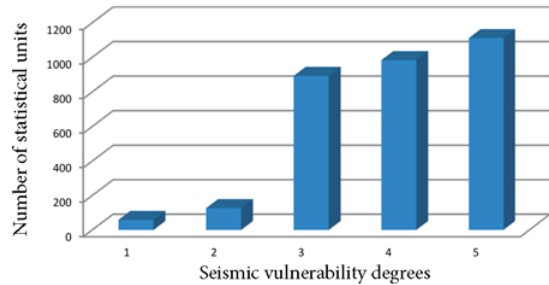
Fig. 5. Number of statistical units for different seismic vulnerability degrees of the map produced based on the association and exception rules